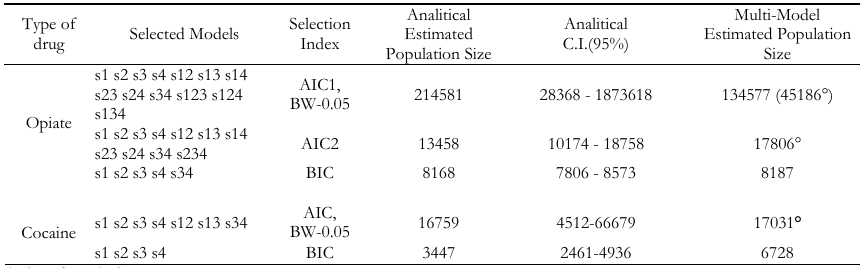
Analysis without covariates (Analytical and Multi-Model